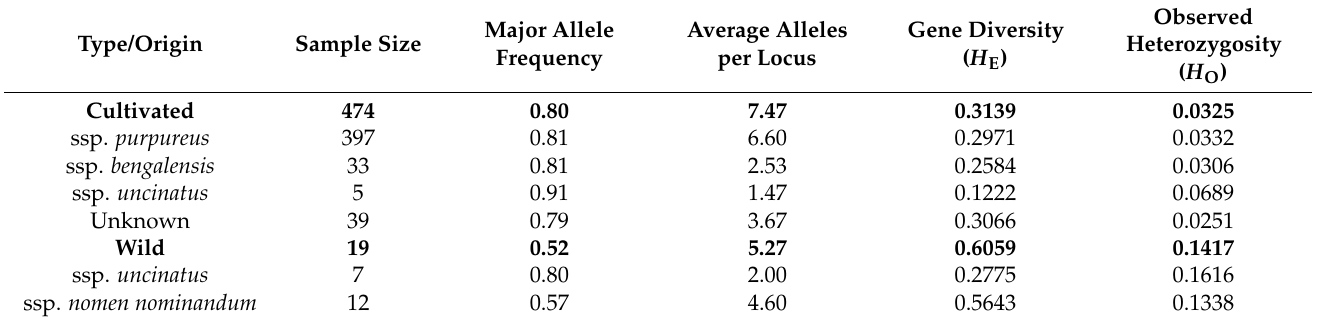
Table 4. Average number of alleles per locus, major allele frequency (MAF), gene diversity (H E ) and observed heterozygozity (H O ) in different subspecies/types of 493 lablab accessions detected by 15 nuclear SSR